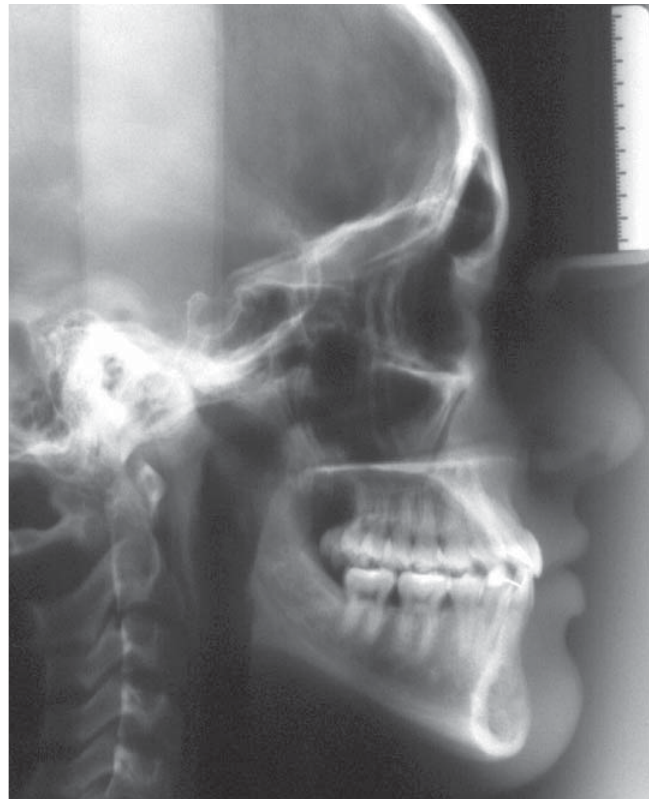
FIGURE 9- Posttreatment panoramic radiograph